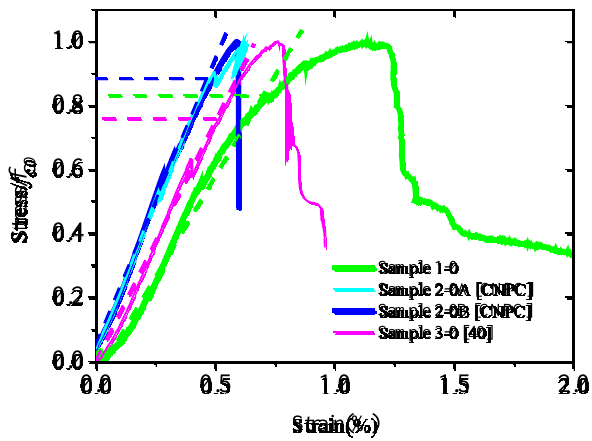
σ p 0 based on uniaxial